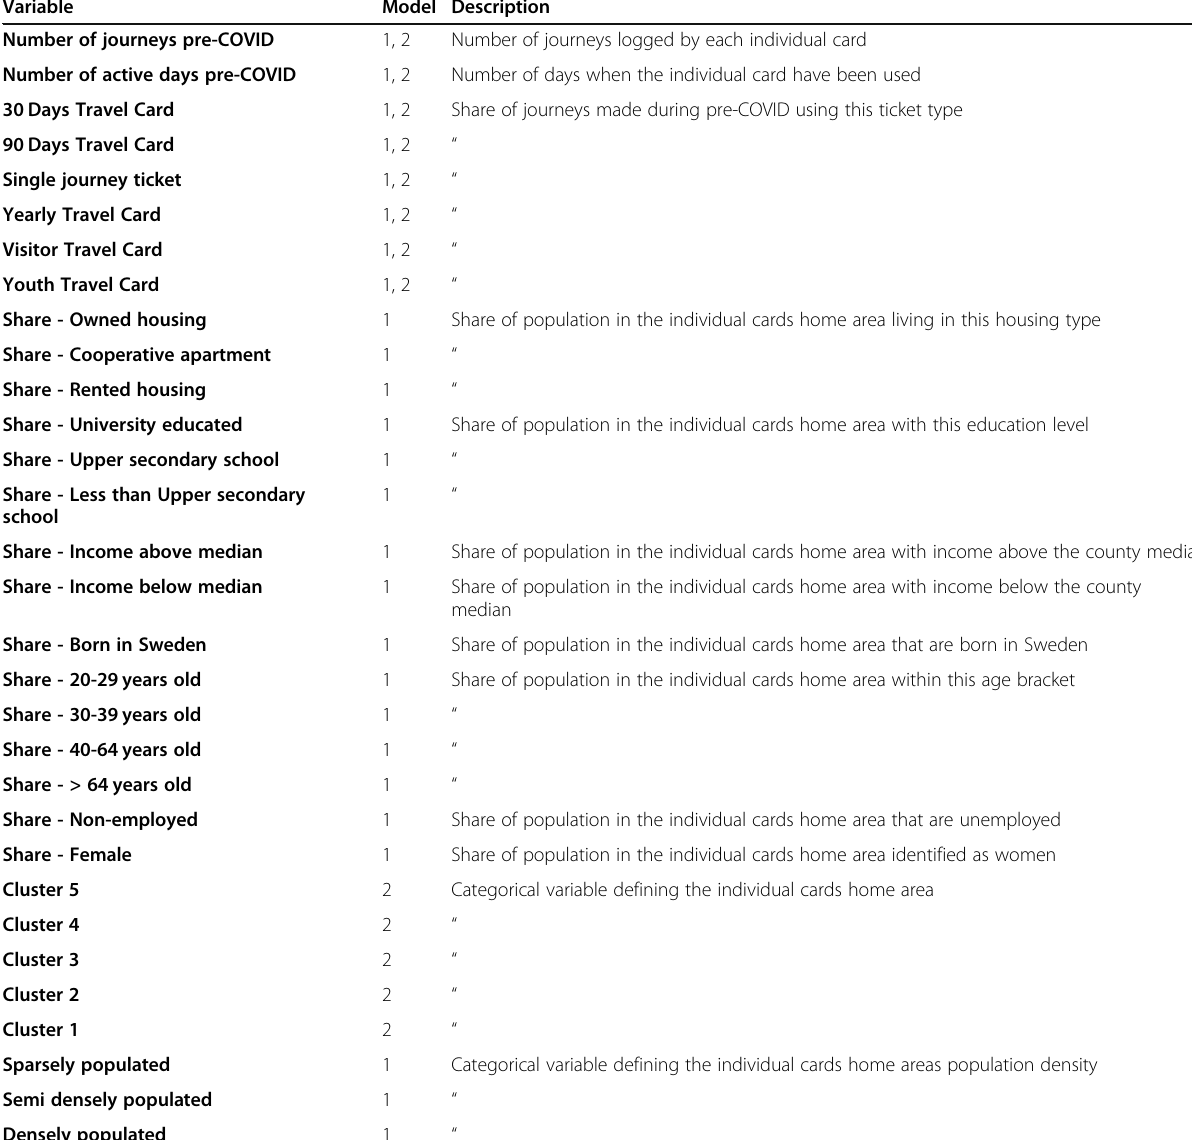
Table 3 Included variables in models 1 and